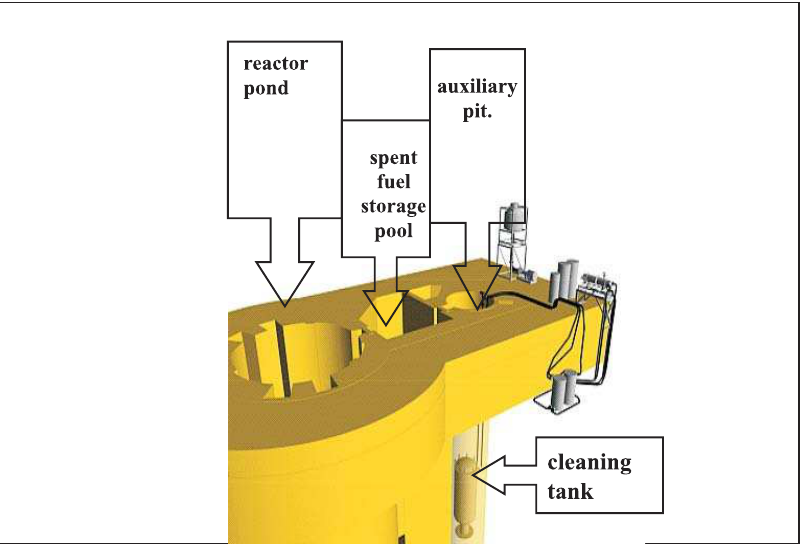
Fig. 1 Incident location at Unit 2 of NPP Paks. (The figure is taken from the website of the NPP